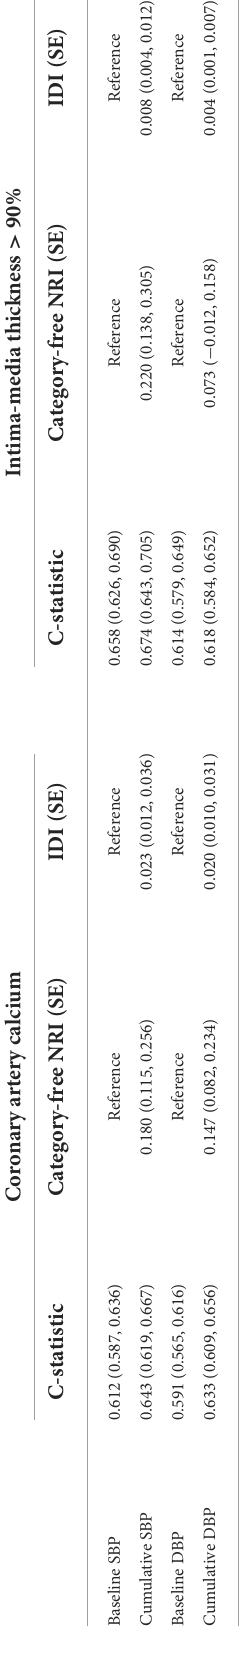
TABLE 3 Association between intensity of hypertensive exposure and intima-media